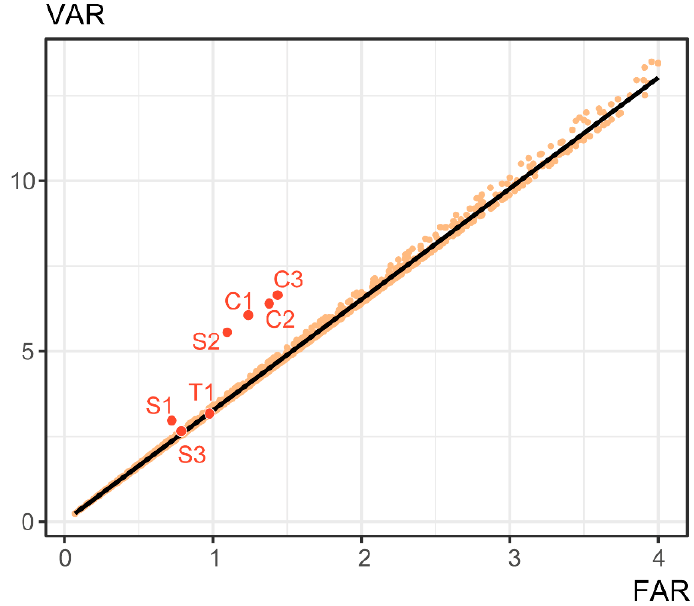
Figure 10. Iteration-based linear regression analysis of urban density metrics, FAR and VAR. Case studies are marked in red with labels (codes explained in Figures 5 and 6).